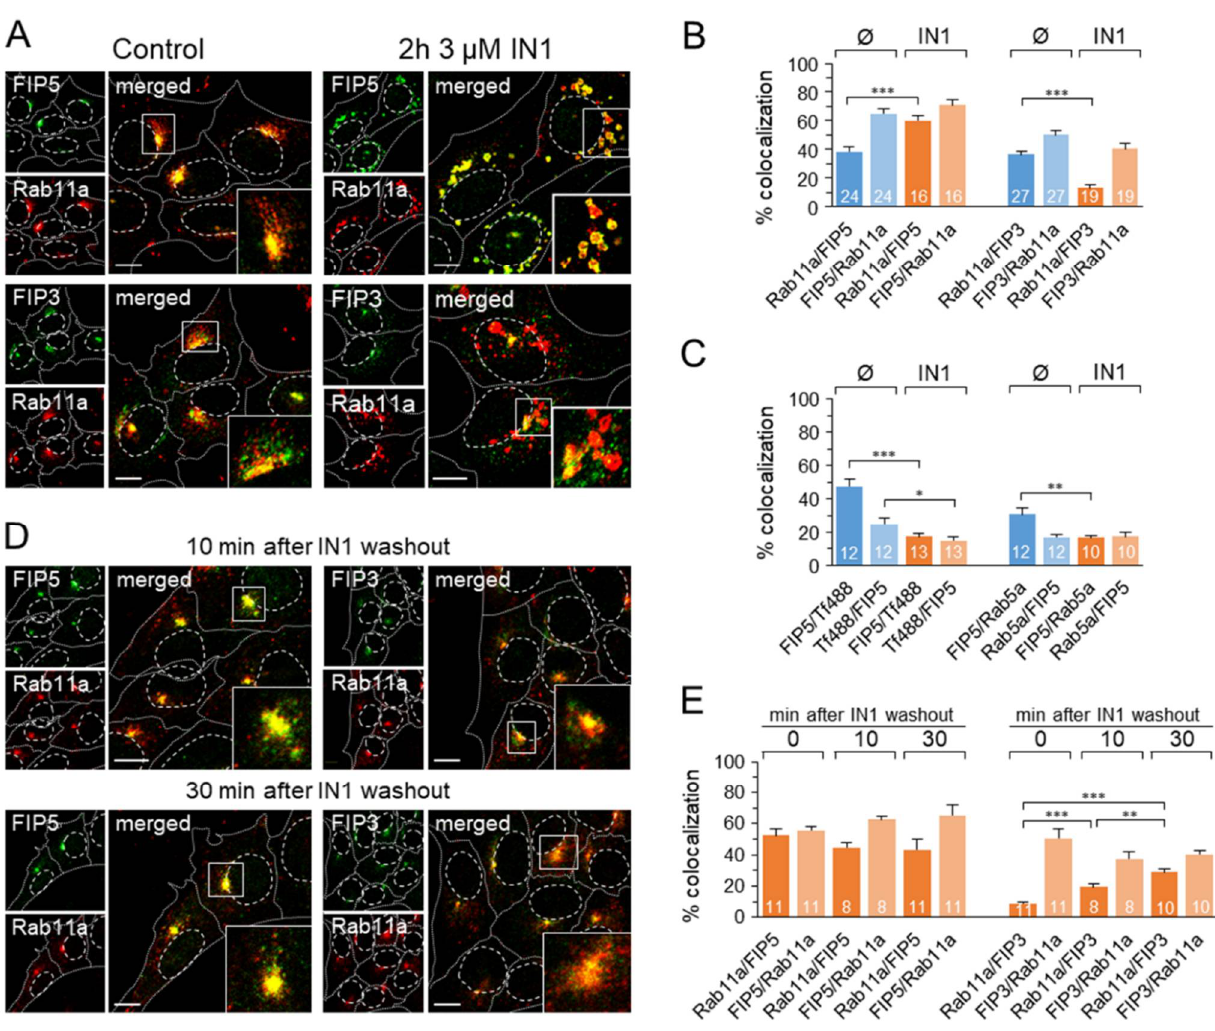
Figure 7. Rab11a endosomes of PI3P-depleted cells are positive for Rab11-FIP5 but not Rab11-FIP3. Representative images ( A ) and 3D colocalization analysis ( B ) of Rab11a and Rab11-FIP5 (FIP5) and Rab11-FIP3 (FIP3), in control (Ø) and 2 h IN1-treated cells (3 μM). Data represent mean ± SEM (number of cells indicated within bars) of M1/M2 coefficients of pixel overlap per cell, measured across the Costes-algorithm thresholded z-stacks of confocal images; *** p < 0.001 (two-tailed t -test). ( C ) The 3D colocalization (M1/M2 coefficients of pixel overlap) of FIP5 with internalized Tf-AF 488 (45 min internalization) and endogenous Rab5a in control (Ø) and 2 h IN1-treated cells (3 μM). Data represent mean ± SEM per cell (number of cells indicated in bars); *** p < 0.001, ** p < 0.01, * p < 0.05 (two-tailed t -test). Representative images are presented in Figure S13. Representative images ( D ) and 3D colocalization analysis ( E ) of Rab11a and FIP5 or FIP3 in 2 h IN1-treated cells (3 μM) after 10 and 30 min of IN1 washout. Data represent mean ± SEM of M1/M2 coefficients of pixel overlap per cell ( n = 8–11); *** p < 0.001, ** p < 0.01 (two-tailed t -test). The insets present zoomed area box. Cell borders are indicated by fine dotted lines and cell nuclei by fine dashed lines. Bars, 10 μm.